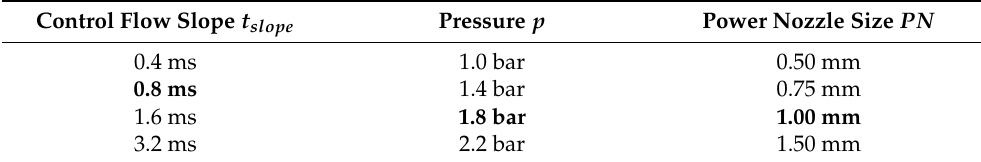
Table 1. Variations for the parametric simulations. Baseline values are printed in bold